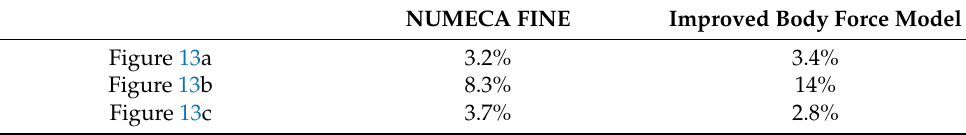
Figure 13. Comparison of Rotor 37 flow characteristics at outlet along the span. ( a ) Total pressure ratio distribution; ( b ) Swirl angle distribution; ( c ) Total temperature distribution; and ( d ) Mach distribution. Table 2. The errors in the comparisons with the experimental data.